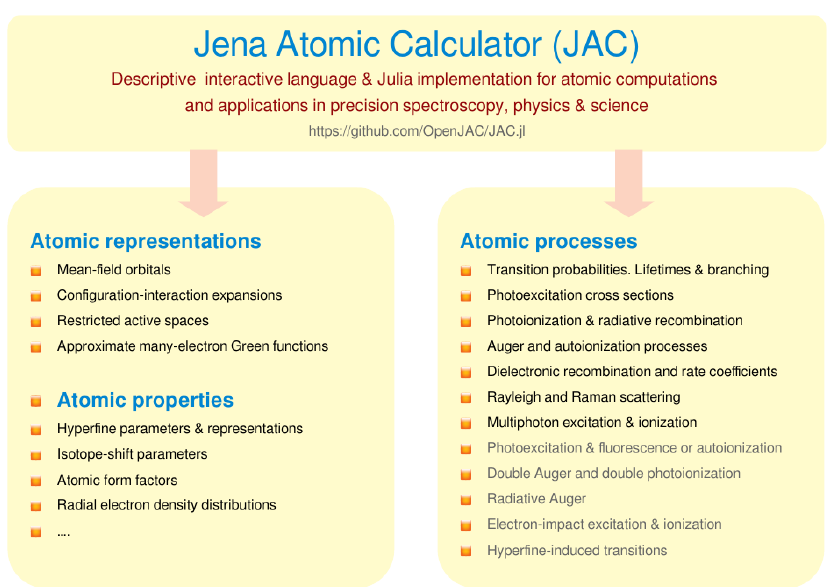
Figure 5. Selected applications of the J AC toolbox to generate atomic representations or to compute properties and processes. See Refs. [36,41] for a more detailed account of the various features of this